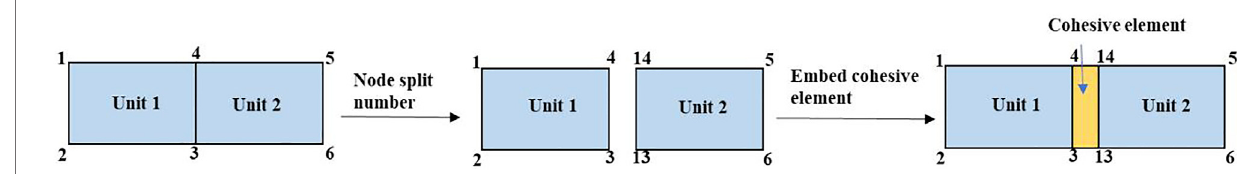
FIGURE 3 | Quadrilateral grid zero-thickness cohesive element embedding.